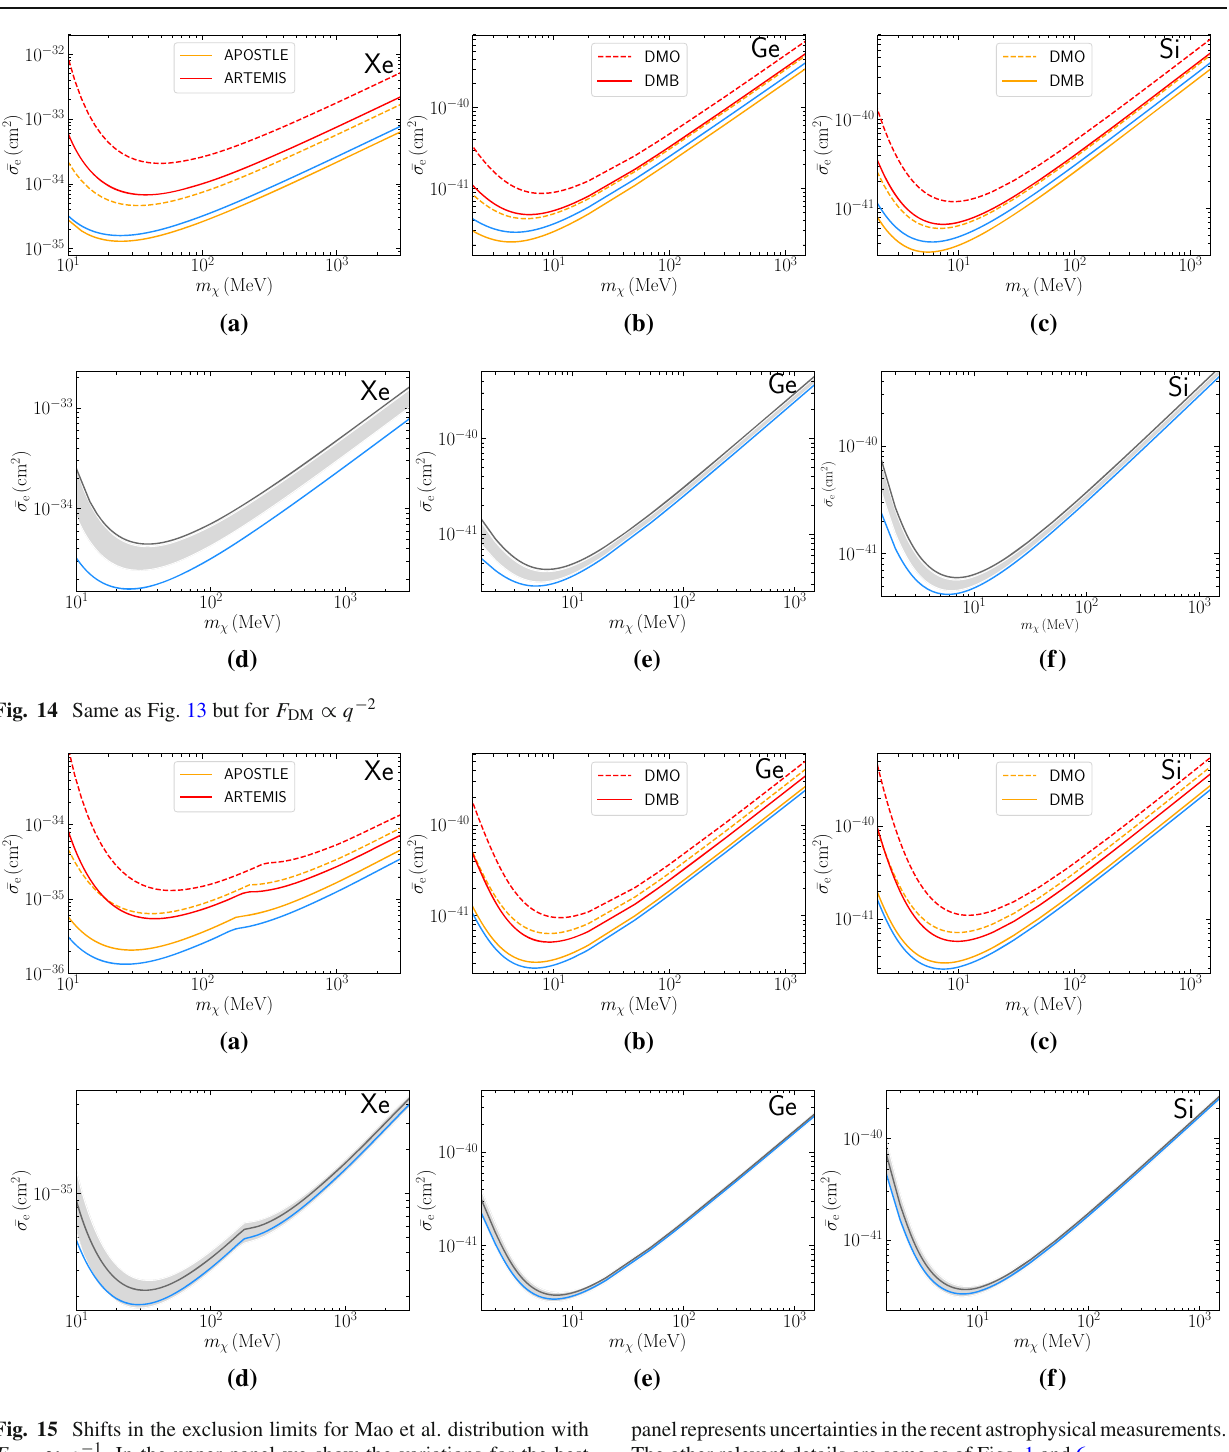
panelrepresentsuncertaintiesintherecentastrophysicalmeasurements. The other relevant details are same as of Figs. 1 and